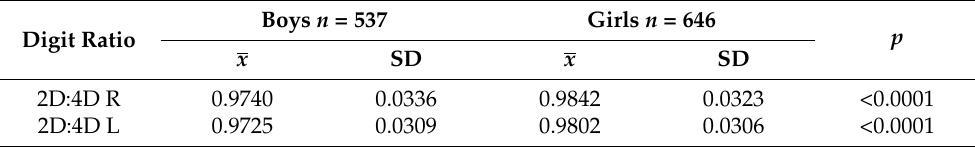
Table 1. Comparison of right and left hand digit ratios in children, by sex.